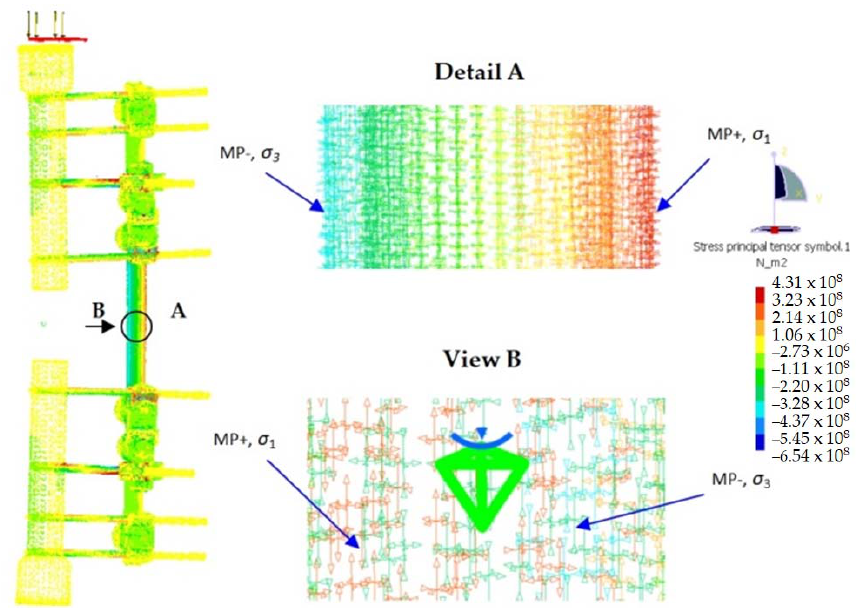
Figure 6. Principal stresses under maximum axial load.